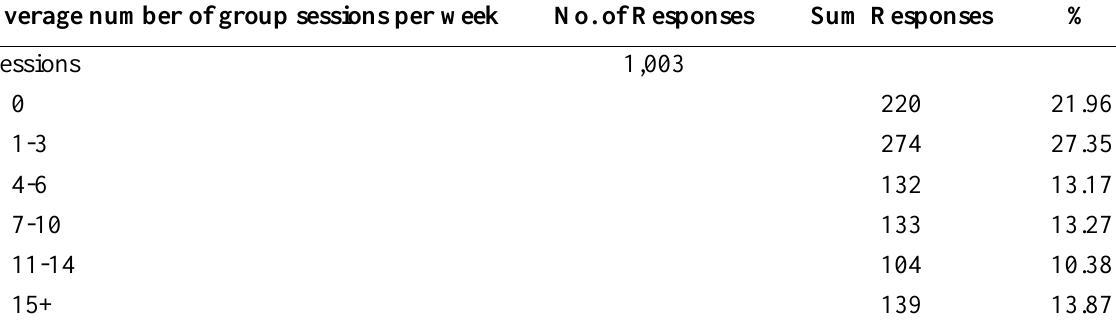
Average Number of Weekly Group Sessions Average number of group sessions per